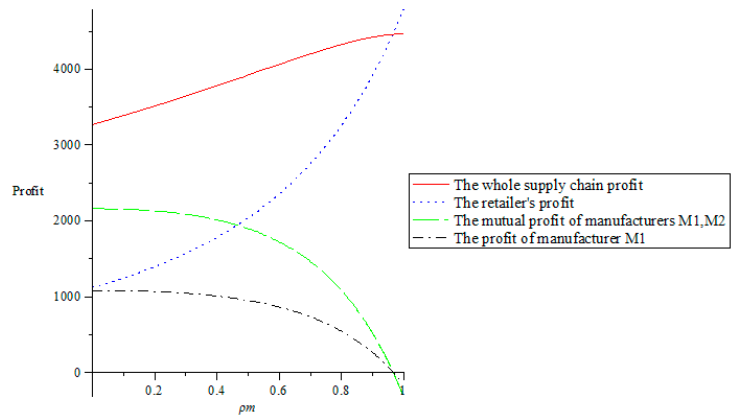
Figure 5. The impact of altruistic preference coefficients of two manufacturers on supply chain profits.